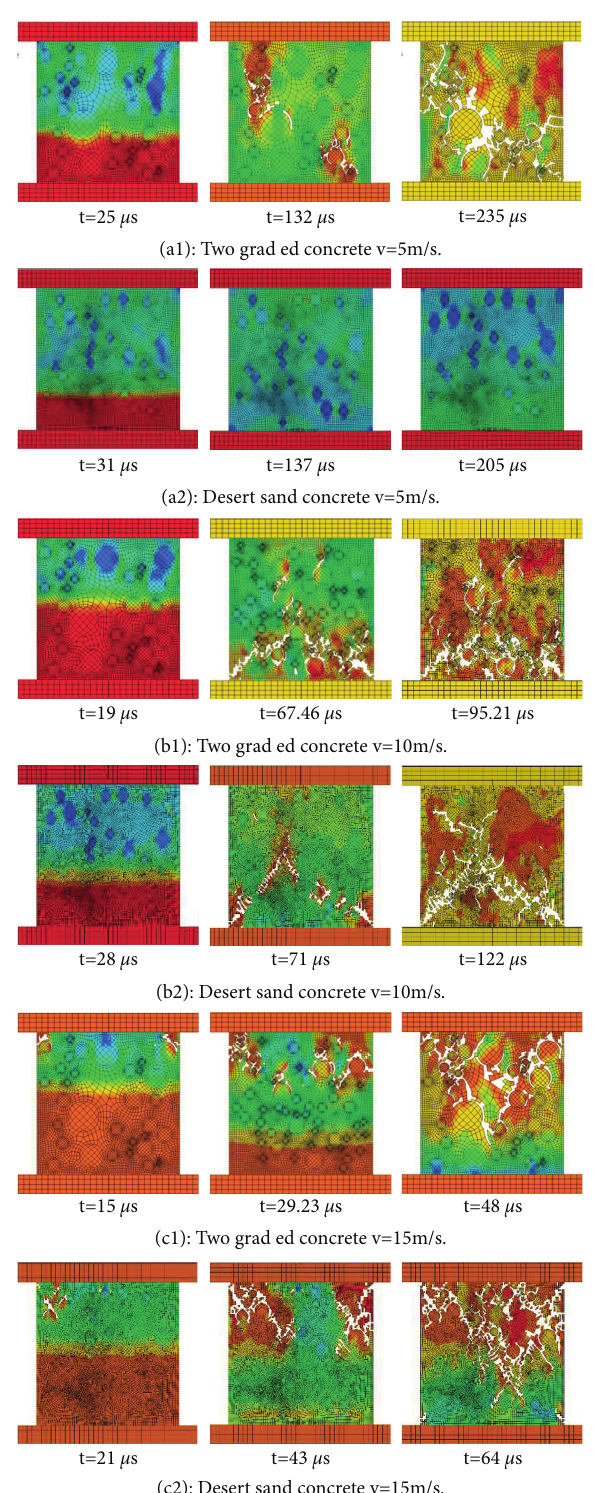
Figure 9: Impact failure process of desert sand concrete and two-graded concrete (150mm × 150mm ×